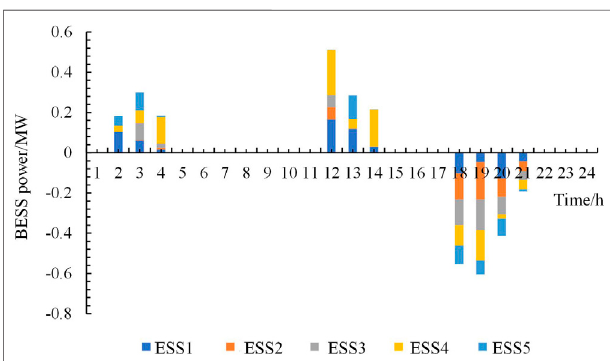
FIGURE 6 | Node voltage of the system.